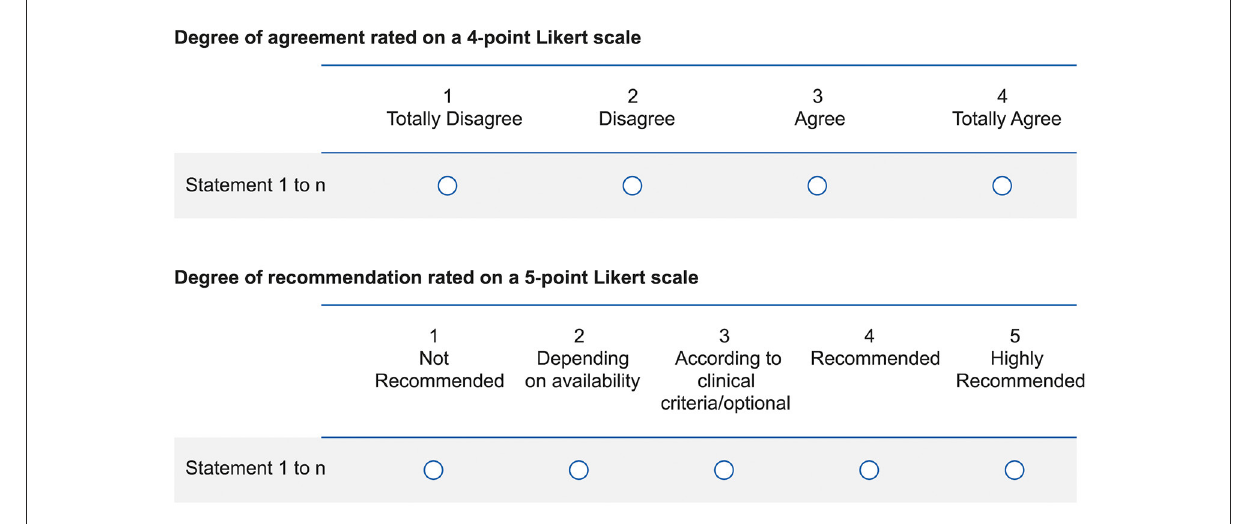
FIGURE1 Likert scales used to rate the